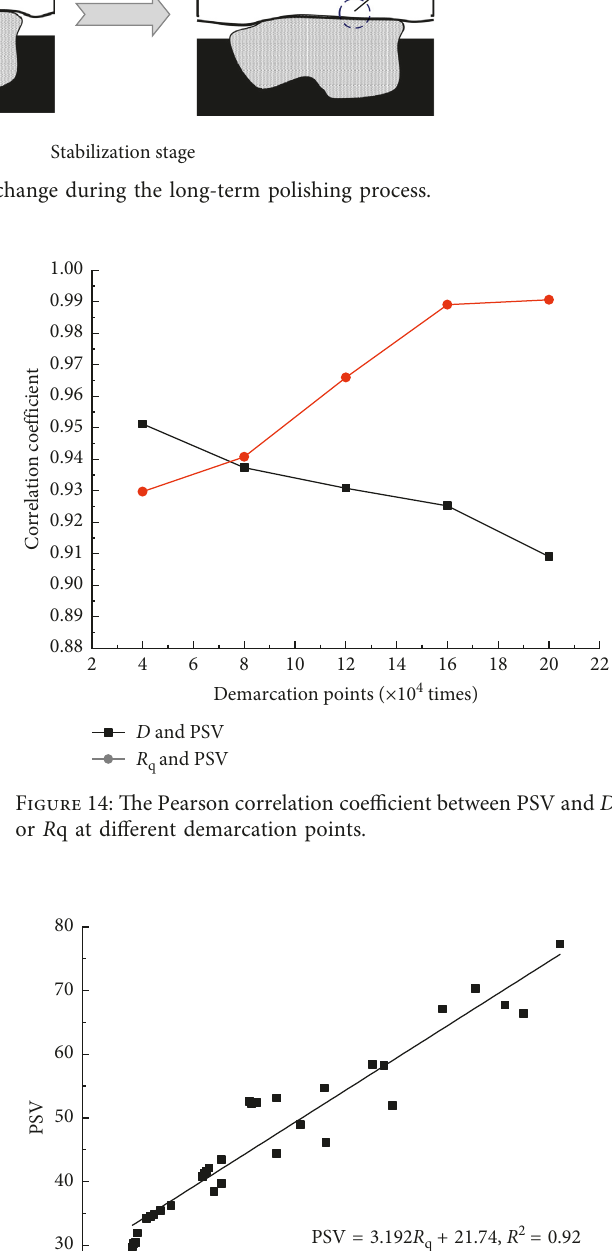
PSV = 3.192 R q + 21.74, R 2 = 0.92